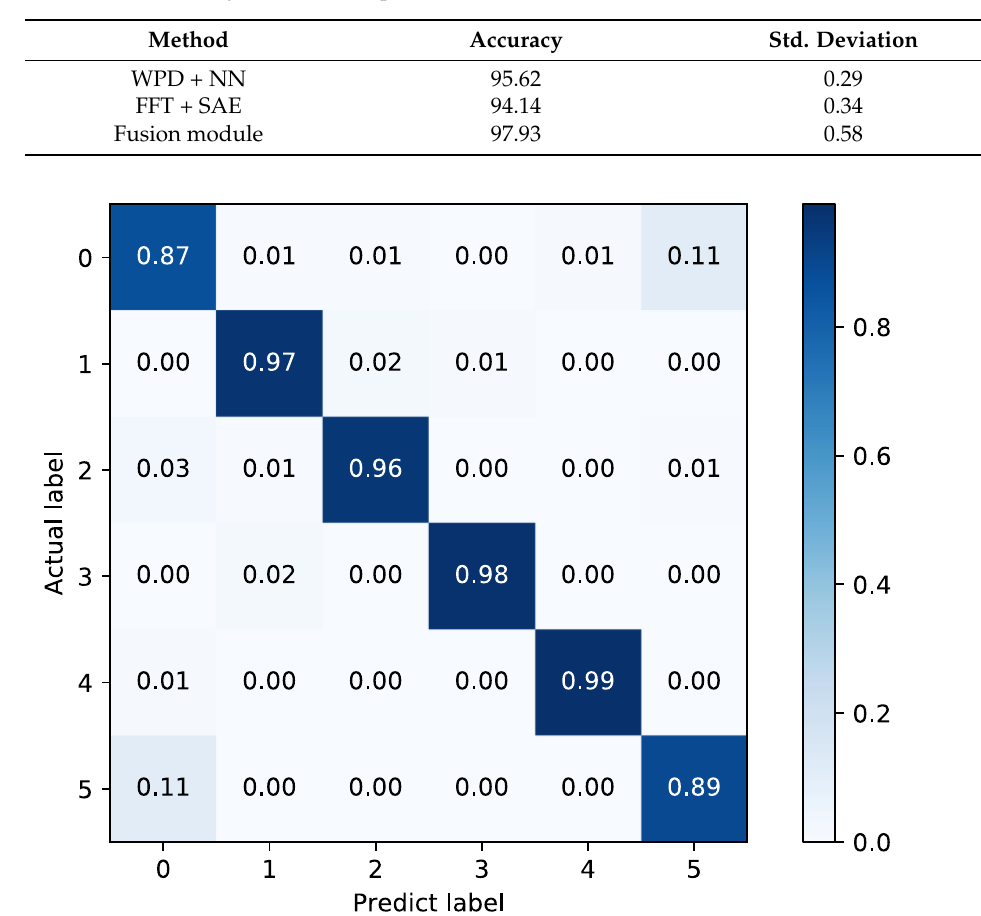
Table 4. The accuracy (%) table comparison with two basic classifiers.